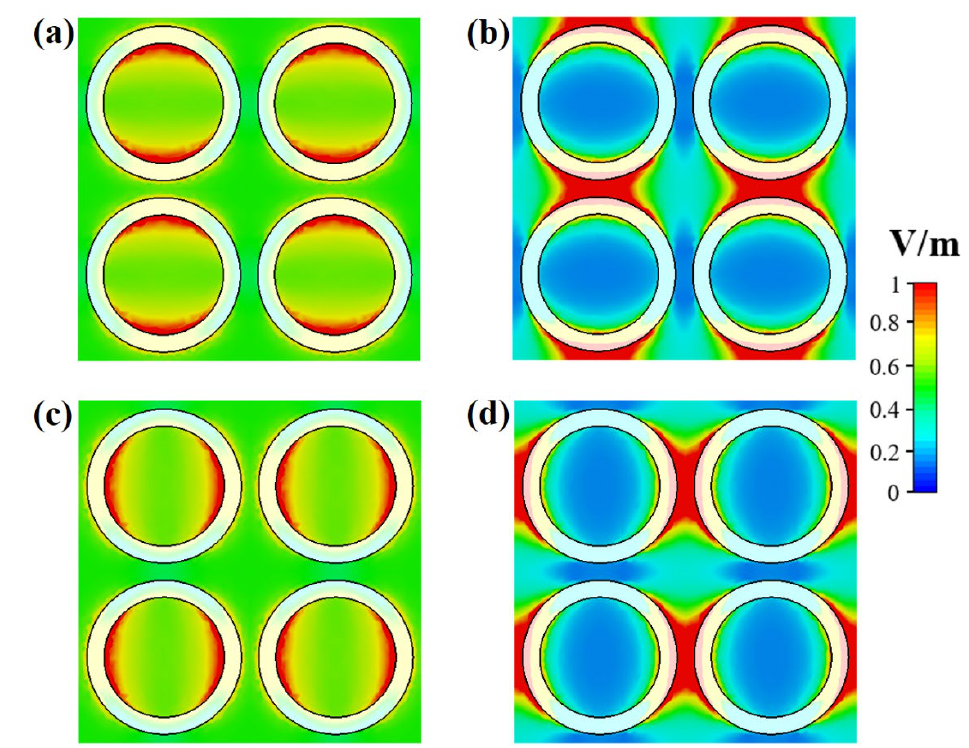
Figure 4. Surface electric field distribution of the proposed NMMA: ( a ) TE-wave polarized at λ = 650 nm, ( b ) TE-wave polarized at λ = 2550 nm, ( c ) TM-wave polarized at λ = 650 nm, ( d ) TM- wave polarized at λ = 2550 nm.